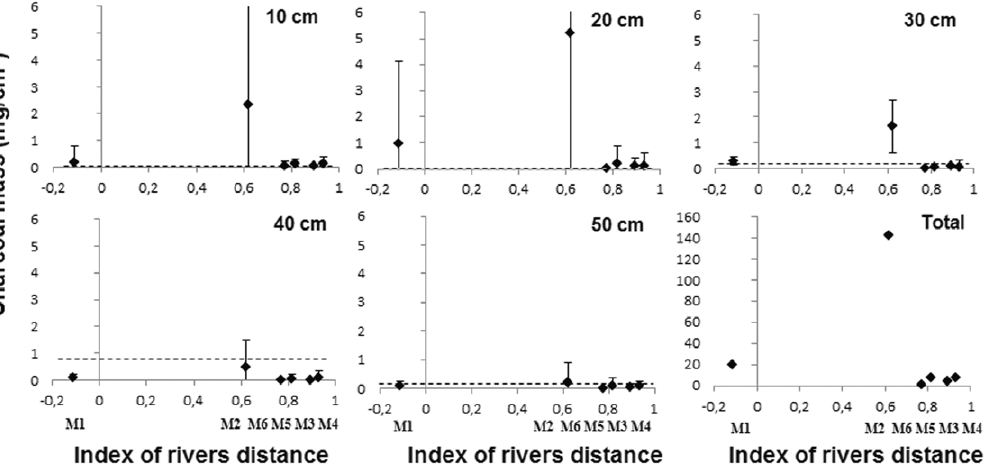
Figure 2. Mass of charcoal in the soil (mg/cm 3 ) for each soil layer from 10 cm to 50 cm in depth. The plots are in order of increasing distance from the sites to the rivers, expressed by the index of rivers distances. Each point is the average mass of charcoal in the soil from 14–15 samples in each area. The vertical lines represent the standard deviation. The dotted line represents the median value of the mass of charcoal found at each depth in the soil of forests north of Manaus in Central Amazonia, which is the value expected in soils without past human activities